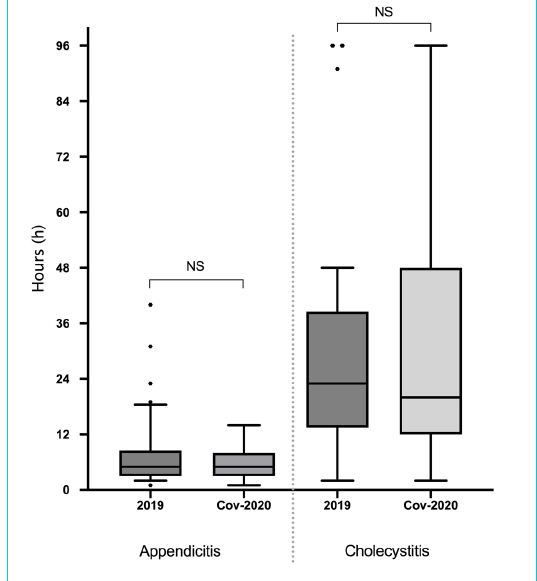
Figure 2: Delay (hours) to surgery after consultation in the emer- gency room for appendicitis and cholecystitis: comparison be- tween 2019 and 2020. Appendicitis: p = 0.687, cholecystitis: p = 0.914. Median (interquartile range), NS: